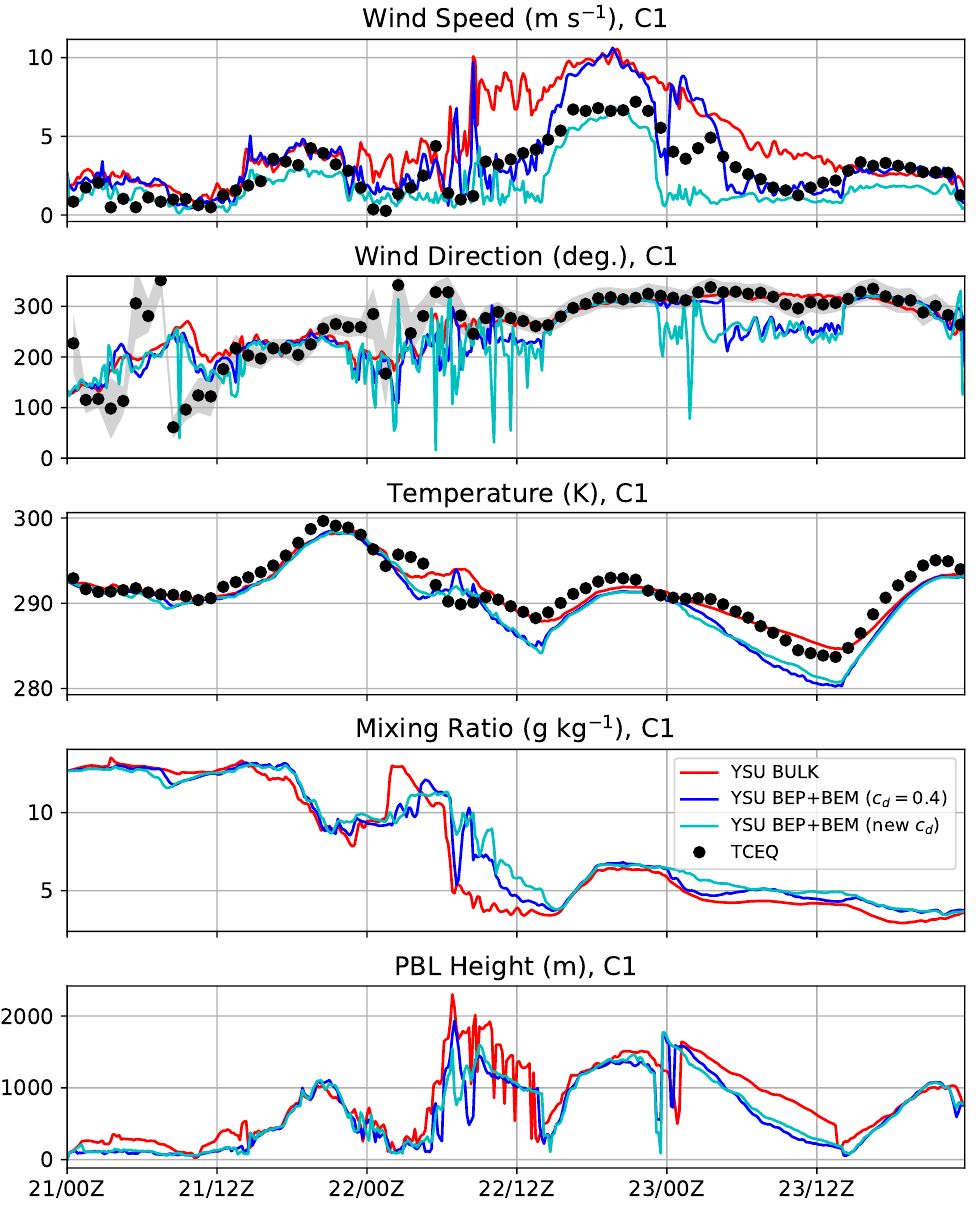
Figure 10. Same as Figure 7 but at LIR station